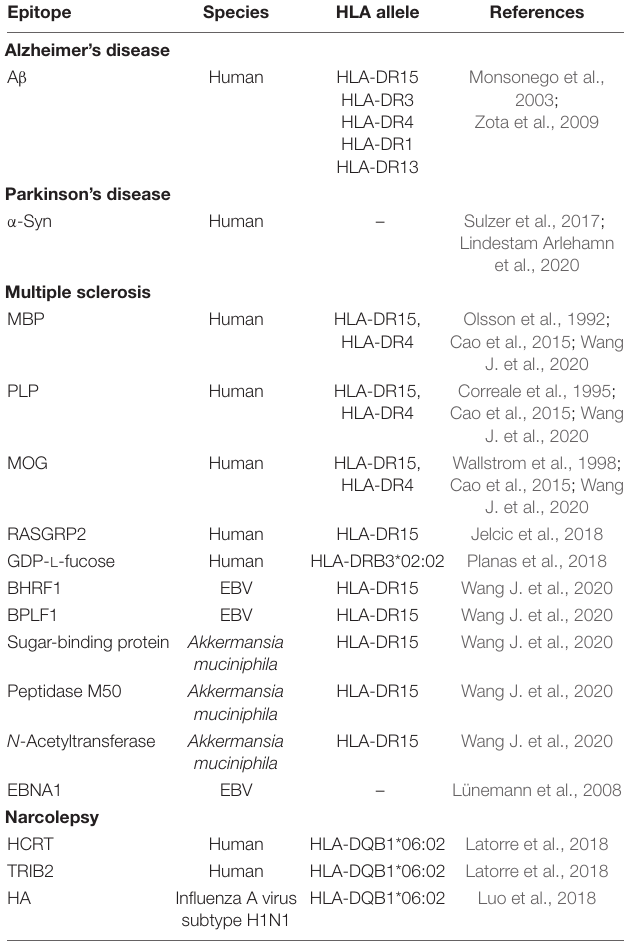
TABLE 1 | T cell epitopes associated with AD, PD, MS, and narcolepsy.